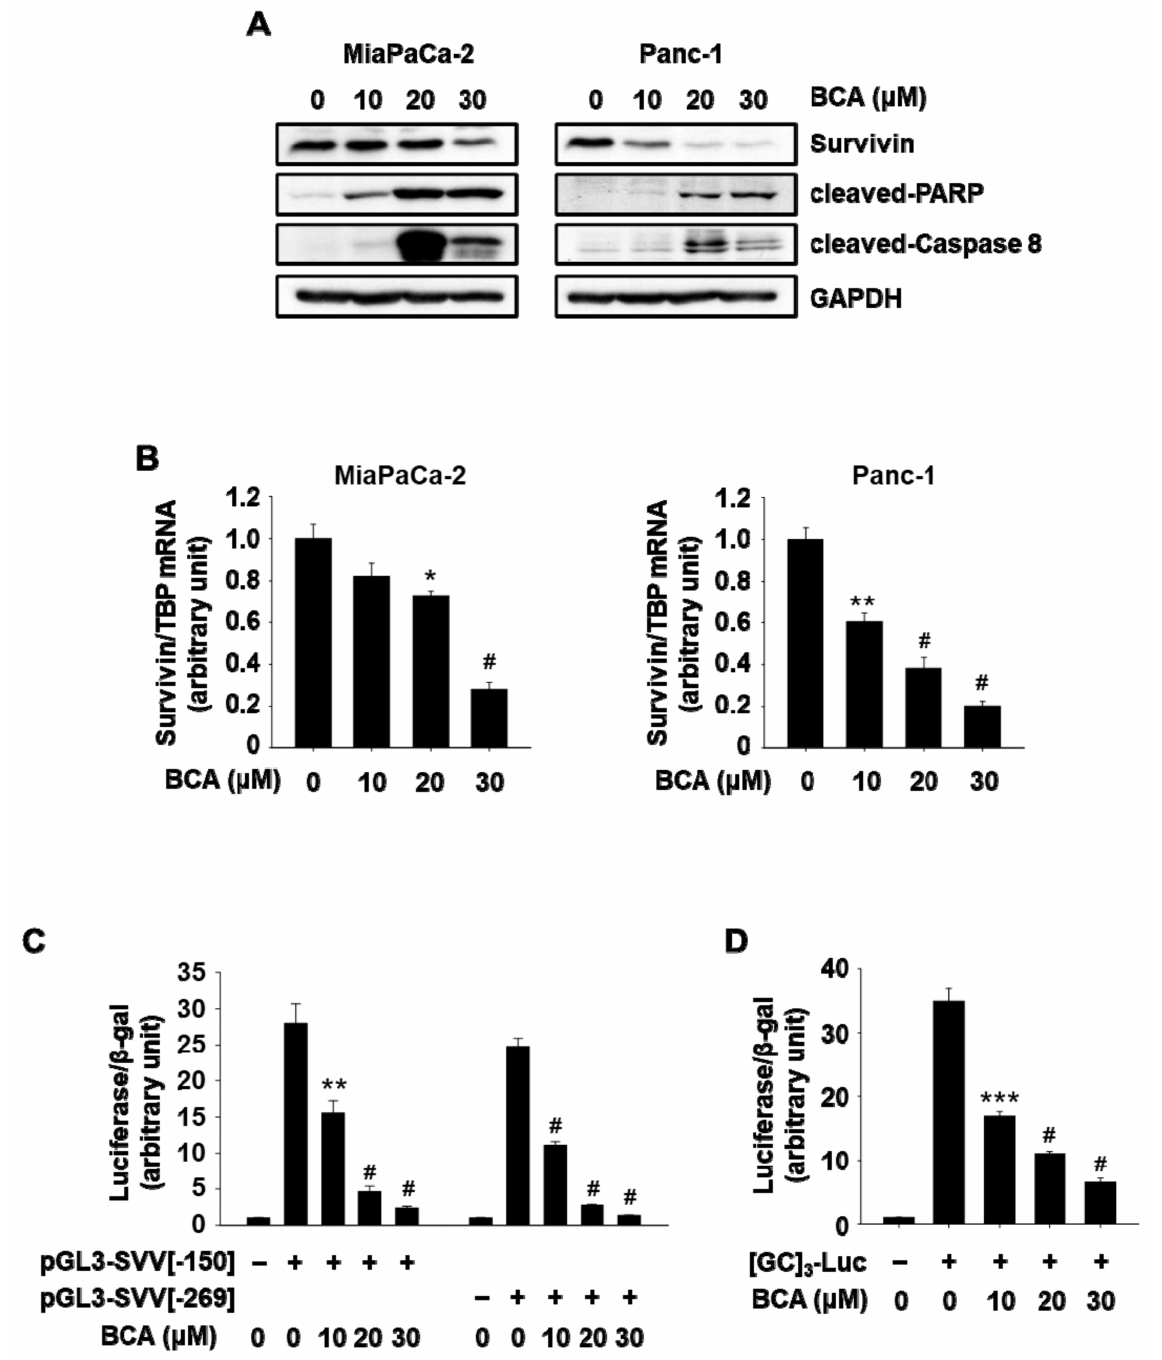
Figure 4. BCA inhibits Sp1-mediated survivin expression and induces apoptosis in pancreatic cancer cells. ( A ) Cells were treated with BCA for 24 h, and whole cell lysates were analyzed by Western blot analysis. GAPDH was used as a loading control. ( B ) Cells were treated with BCA for 18 h, and survivin mRNA level was determined by quantitative real-time PCR as described in the Section 3. ( C ) Panc-1 cells were transfected with 25 ng of pGL3-SVV( − 150) or pGL3-SVV( − 269) for 5 h and then treated with BCA for 18 h. ( D ) Panc-1 cells were transfected with 25 ng of [GC] 3 -Luc for 5 h and then treated with BCA for 18 h. Luciferase activity (relative to β -galactosidase) was determined, and the corresponding empty vector was used as a control. The results are presented as means ± SEM. * p < 0.05, ** p < 0.01, *** p < 0.005, and # p < 0.001 vs.